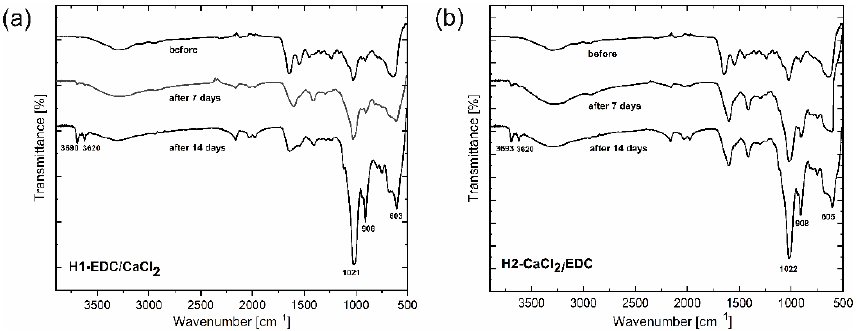
Figure 10. FTIR spectra of ( a ) the hydrogel H1-EDC/CaCl 2 and ( b ) the hydrogel H2-CaCl 2 /EDC before and after 7 and 14 days of incubation in SBF at 37 °C.